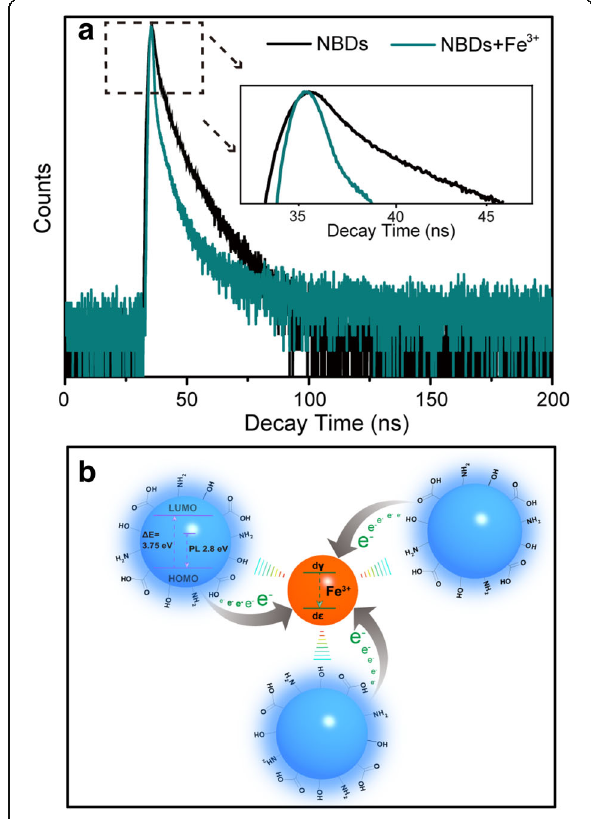
Fig. 6 a Fluorescence decay traces of the NCDs in the absence and presence of Fe 3 + under excitation at 370 nm and emission at 445 nm. b Schematic illustration for the possible fluorescence quenching mechanism of the NBDs in the presence of Fe 3 +